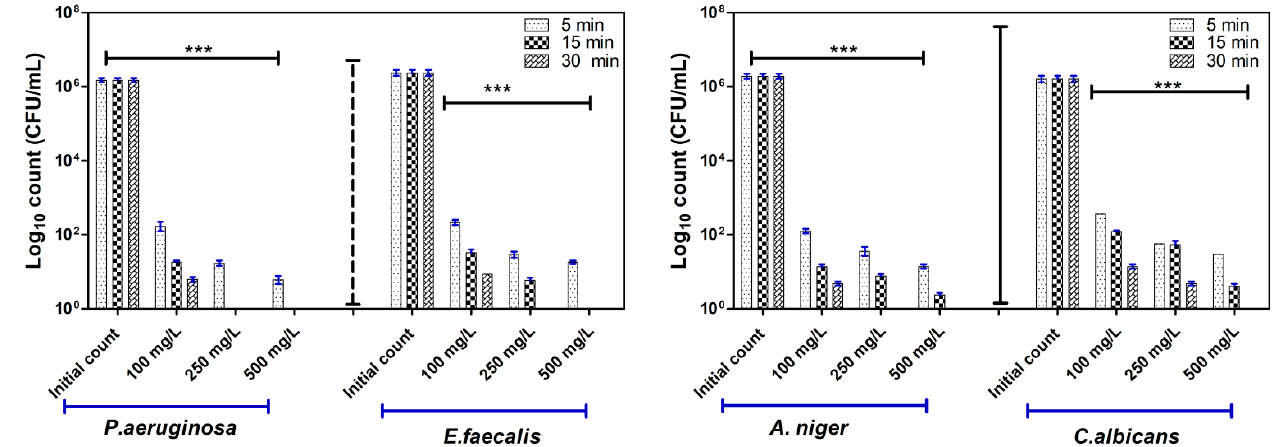
Figure 11. Colony-forming unit and MIC values of AgNPs-3@NFs against human-associated pathogens including P. aeruginosa, E. faecalis, C. albicans, and A. niger . The remaining viable cell populations at various time intervals of 5, 15, and 30 min are shown. Two-way analysis of variance ( ANOVA ) states, * indicates moderate correlation ( p ≤ 0.01), ** indicates high correlation ( p ≤ 0.001), *** indicates high correlation ( p ≤ 0.0001)